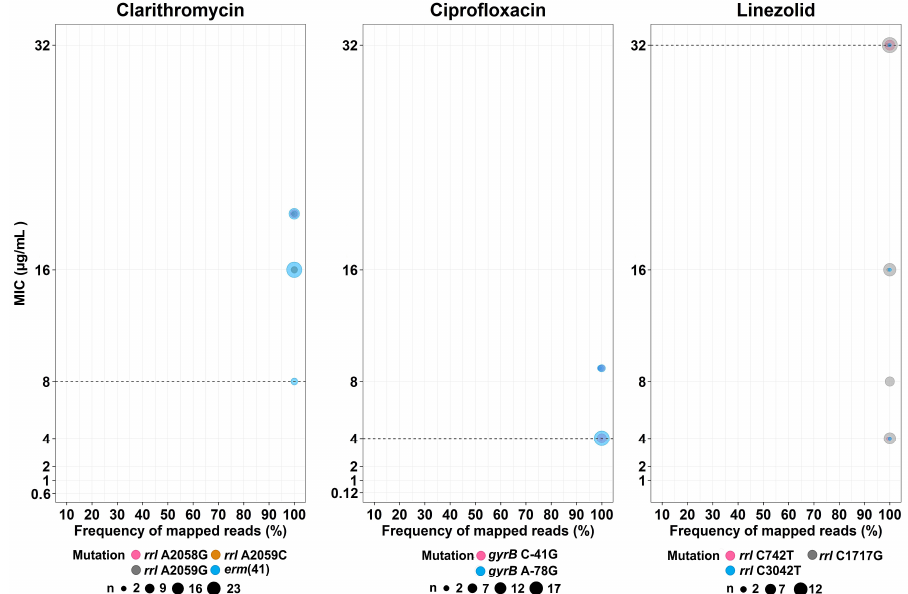
Figure 4. Comparisons between hetero-resistance (inferred from read frequencies of relevant SNPs) and MIC levels. The dashed lines indicate MIC breakpoints that are considered to indicate resistance. Each circle is proportional to the number of